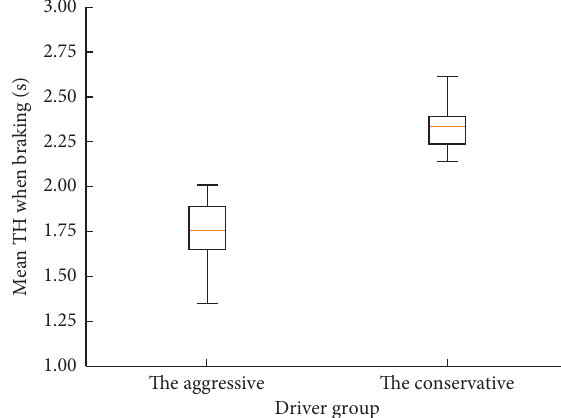
Figure 5: The boxplot of mean TH when braking for the two groups of